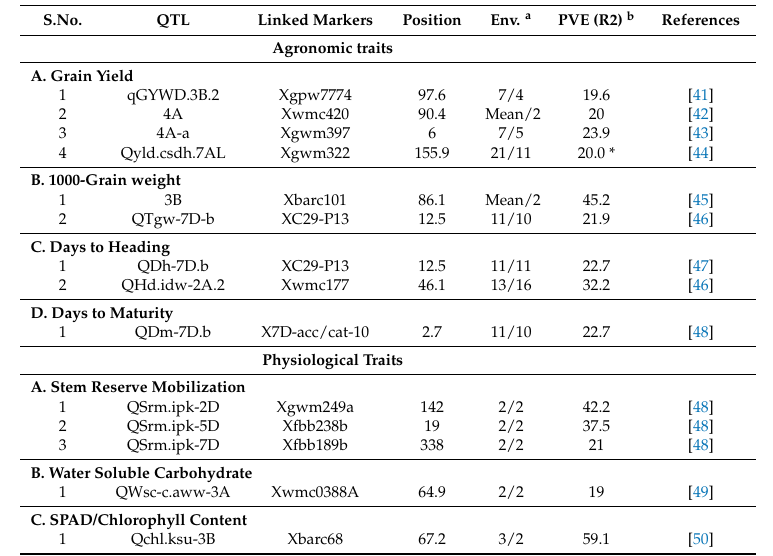
Table 1. Major and stable quantitative trait loci (QTL) with percentages of explained variance (PVE) ranging from 19% to 59% for agronomic and physiological